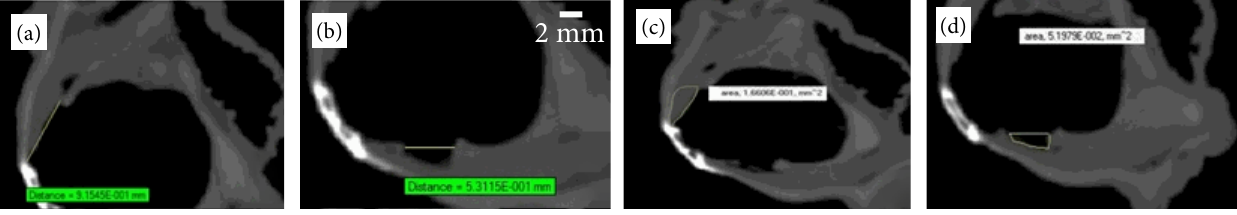
Figure 3 - Micro-CT measurements of the rat vocal fold parameters. (a) Micro-CT measurement of normal vocal fold length, measured from the vocal process of the arytenoid to the attachment of the vocal fold to the thyroid cartilage. (b) Length of controlled endoscopic vocal fold injury, measured from the anterior to the posterior edge of the lack of substance. (c) Surface area of normal rat vocal fold measured form free margin of vocal fold-medial; vocal process of arytenoid- posterior; medial lamina of the thyroid cartilage-lateral; anterior attachment of the vocal fold-anterior. (d) Surface area of vocal fold lesion measured from the deepest point-lateral; posterior edge of lesion-posterior; anterior edge of lesion- anterior; virtual line bridging the anterior and posterior epithelial medial surface.